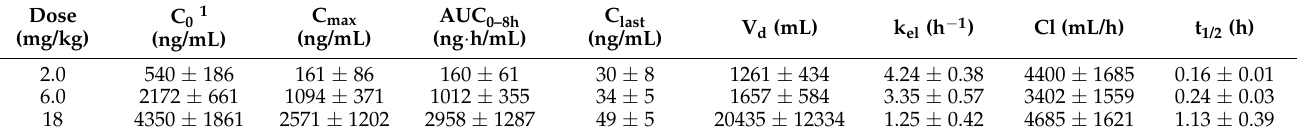
Figure 10. QN23 plasma concentration–time profile after intravenous administration and values of AUC 0–8h (AUC t ) and C max versus dose. Data represented as mean ± SE of 6 independent animals. AUC, area under the curve. Table 1. Pharmacokinetic parameters of QN23.